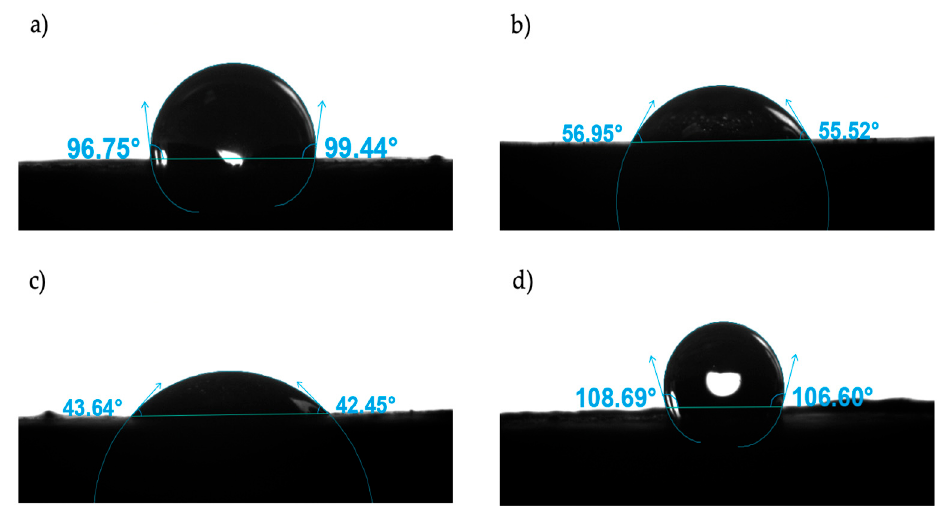
Figure 6. Contact angles to ( a ) water and ( b ) oil for an oil-wettable system, and for ( c ) water and ( d ) oil for an oil-wettable system after being treated with aqueous dispersions of Si07 at 100 ppm at 77 °C for 24 h. All the measures were made at 25 °C.